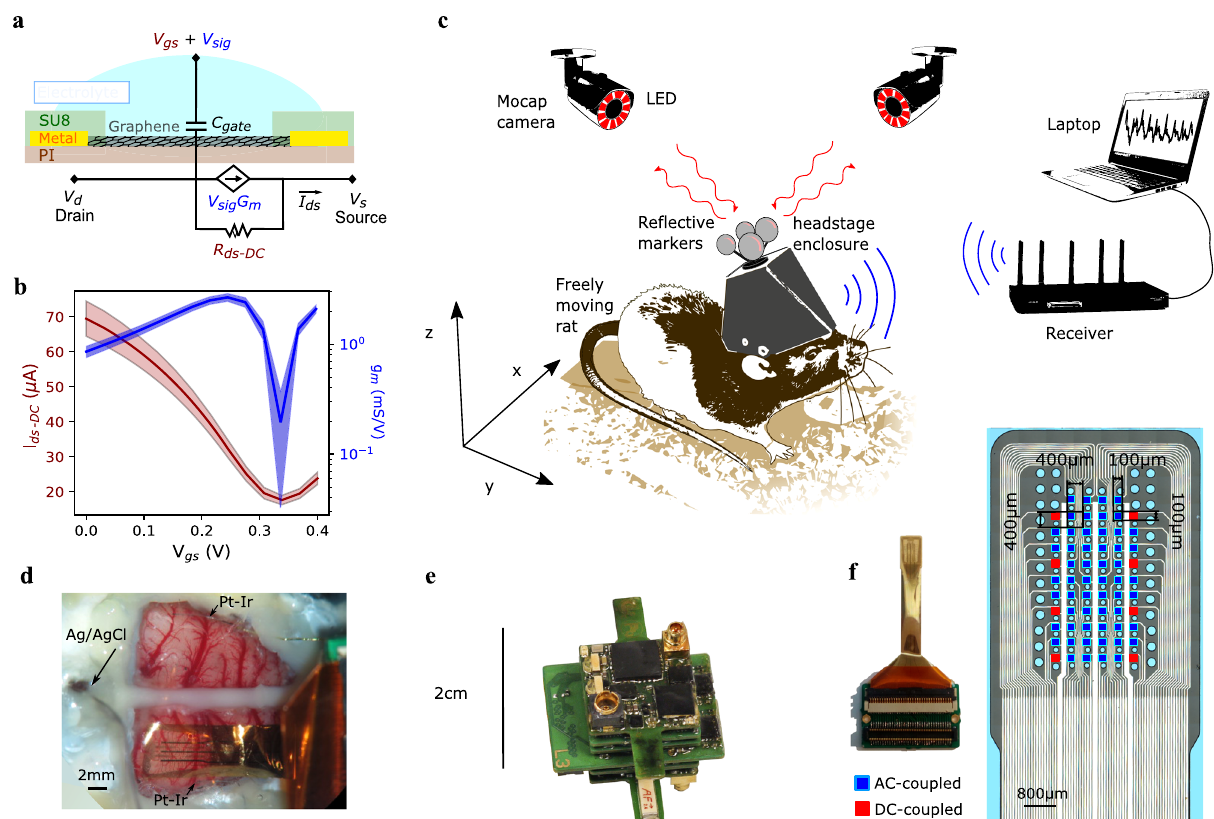
Fig. 1 Graphene active sensor arrays for chronic, wireless monitoring of wide frequency band epicortical neural activity. a Schematic of a g-SGFET and its equivalent circuit. The small-signal transduction from voltage to current is modeled by the current source G m V sig , where G m ≡ d I ds / d V gs . The DC current is modeled by the R ds element. b Average stationary transfer characteristics of 8 g-SGFETs (left axis) and the g m of 64 g-SGFETs (right axis). The fi lled area indicates the standard deviation. c Illustration of the rat with the untethered recording system implanted. The headstage and the 3D-printed frame to hold it are covered by a 3D-printed enclosure. On top, the position markers of the motion capture (Mocap) system are fi xed, which re fl ect light back to the Mocap cameras placed in the room. The neural signals transduced by the graphene sensors are digitized and transmitted wirelessly to the signal receiver, which is connected to a computer for signal recording. d g-SGFET array placed on the rat cortex; the position of the reference electrode in contact with the cerebellum and two Pt-Ir electrodes at either side of the g-SGFET array are marked with arrows. e Photograph of the wireless headstage designed for these experiments. f Photograph of the 64 g-SGFET array mounted on a customized connector (left) and zoomed image of the probe active area (right). The red squares indicate the g-SGFETs on the array, which are connected to the headstage inputs with DC